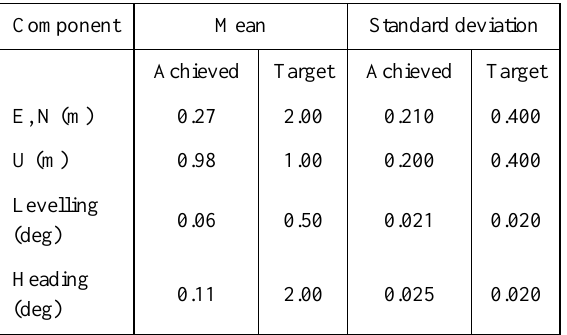
Table 9: Achieved and target requirements for typical